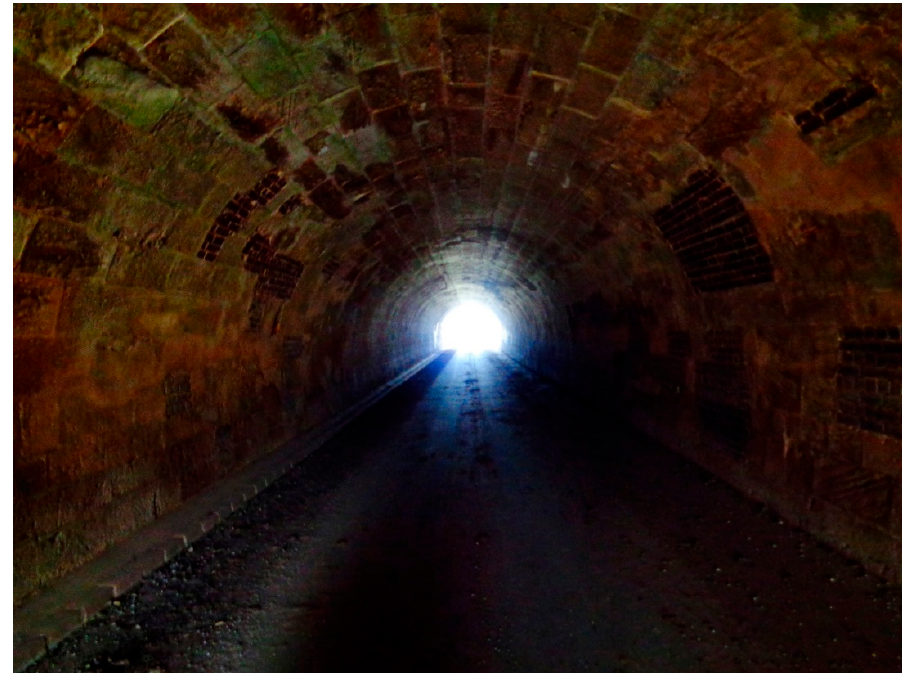
Figure 9. “Light at the End of the Tunnel.” Wikimedia Commons (photo by Stiller Beobachter).